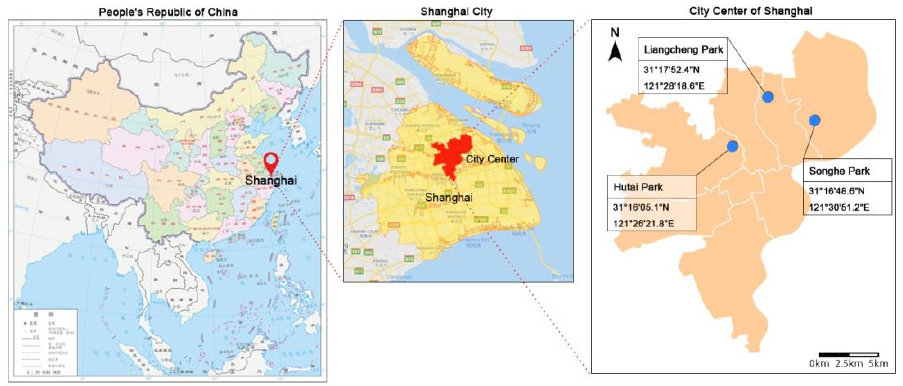
Figure 1. Locations of the study sites (Sources: Gov.cn [56], Google Maps [57]).